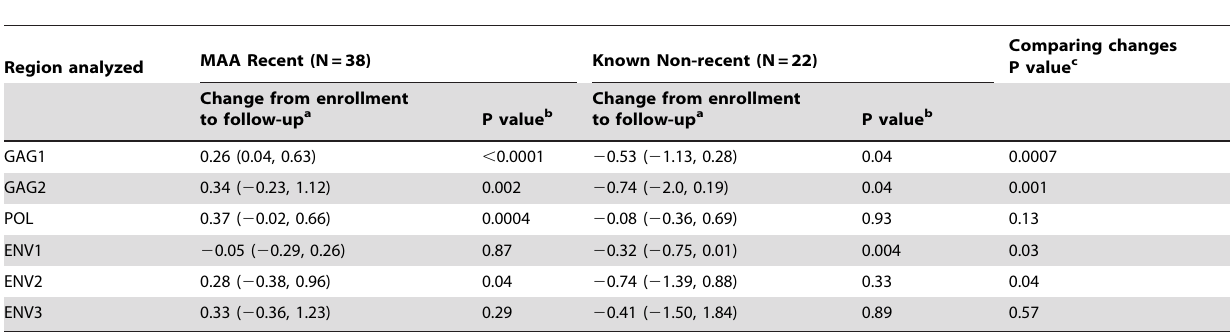
Table 5. Comparison of the change in HIV diversity between enrollment and follow-up in women in the MAA recent and known non-recent groups (paired